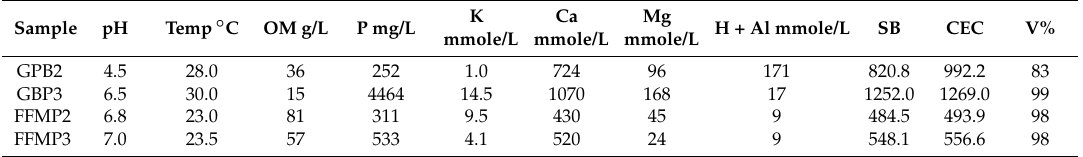
Table 2. Physicochemical analysis of cave sediment samples.